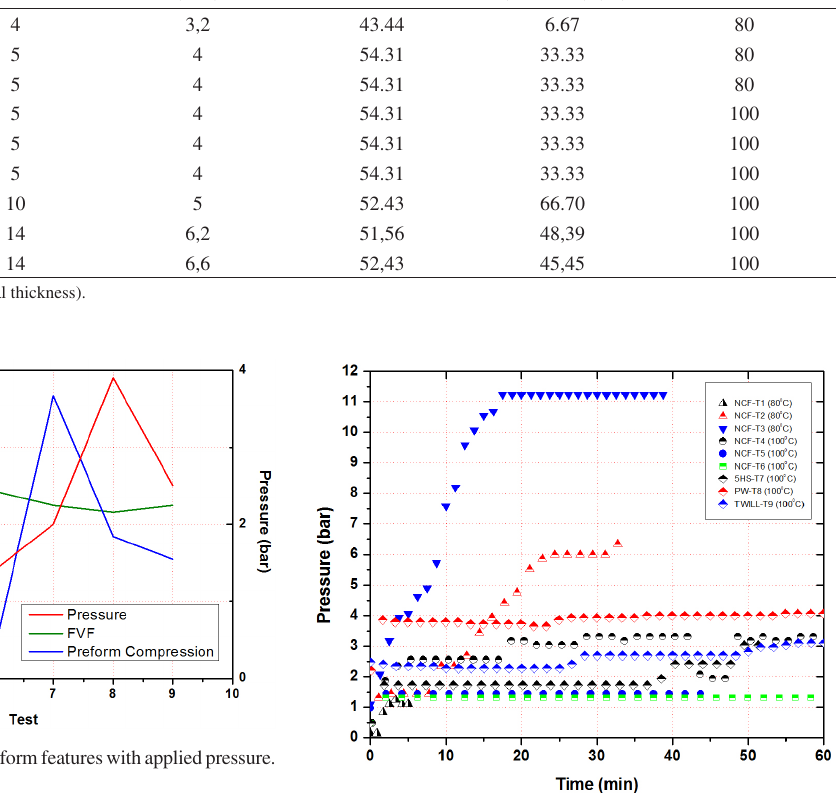
Figure 6. Pressure development of the 9